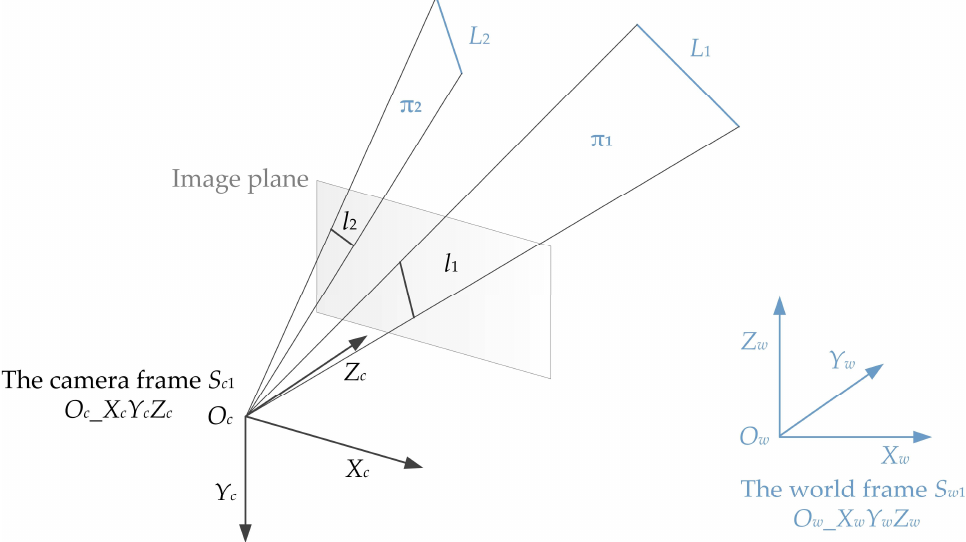
Figure 1. Two 3D lines and their projections in our proposed method.